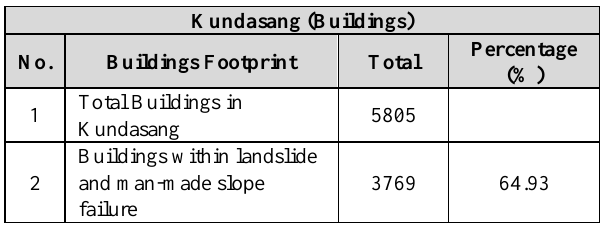
Table 7. Statistics of selected buildings within 100 meters